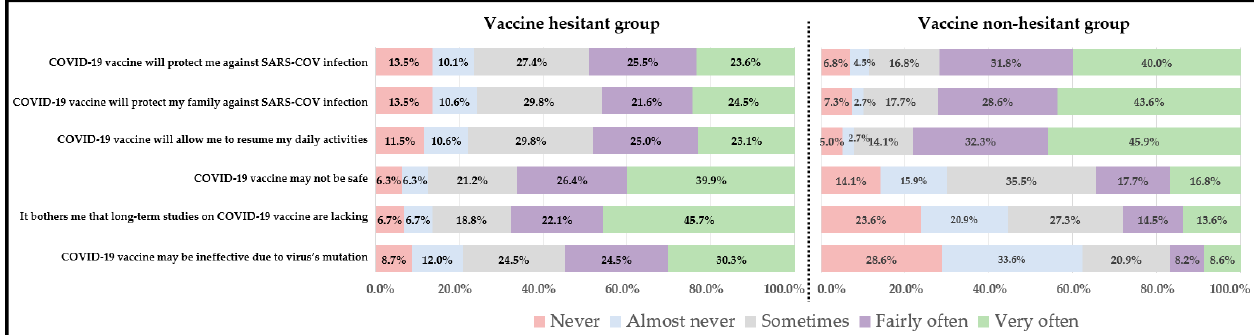
Figure 2. Perceived advantages and disadvantages of COVID-19 vaccination among hesitant and non-hesitant group. Table 3. Comparison of Multi-theory model (MTM) constructs among vaccine-hesitant and non-hesitant groups. MTM Construct